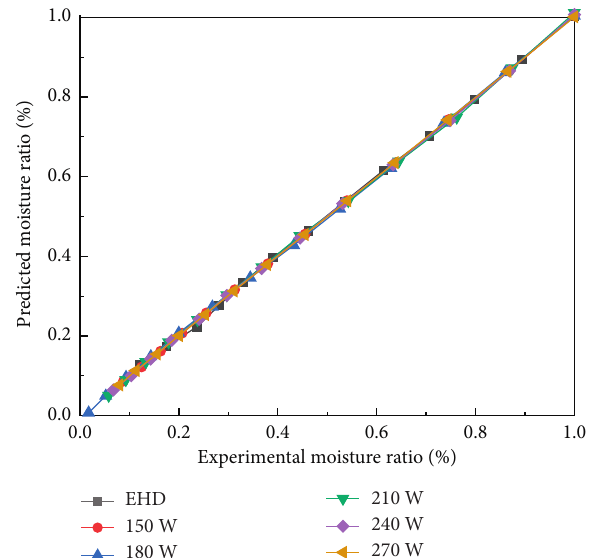
Figure 10: Moisture ratio predicted by the logarithmic model and the experimental moisture ratio.